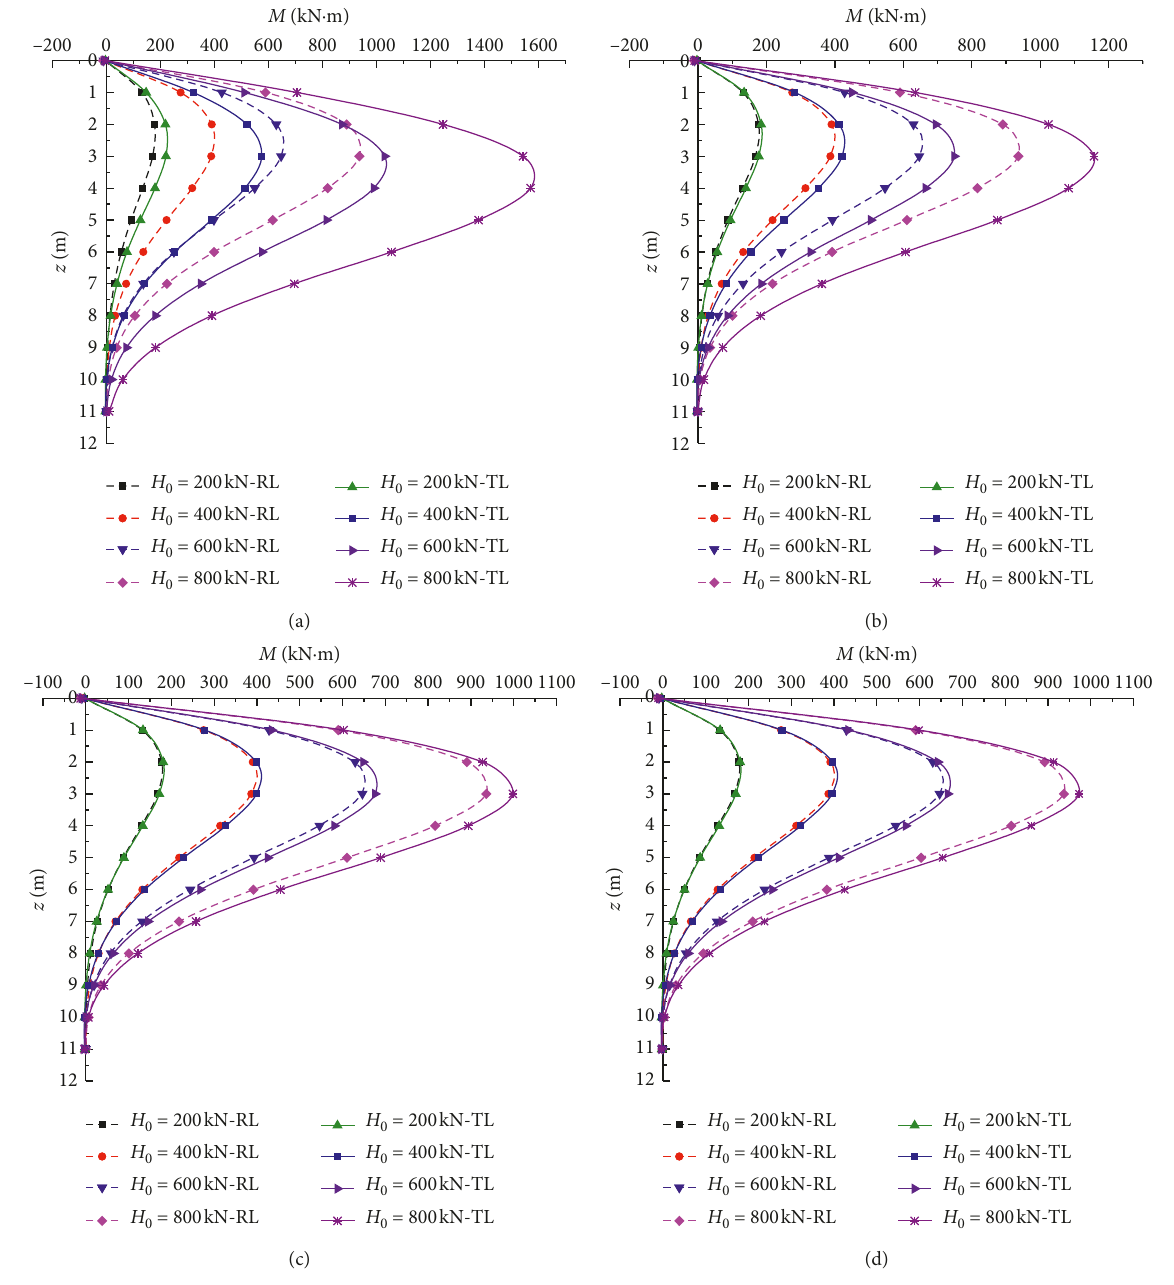
Figure 19: Bending moment of the pile versus depth relationships under different loading directions for the 1V :1H slope. (a) B / D B / D 3. (c) B / D 5. (d) B / D (cid:31) (cid:31) (cid:31)